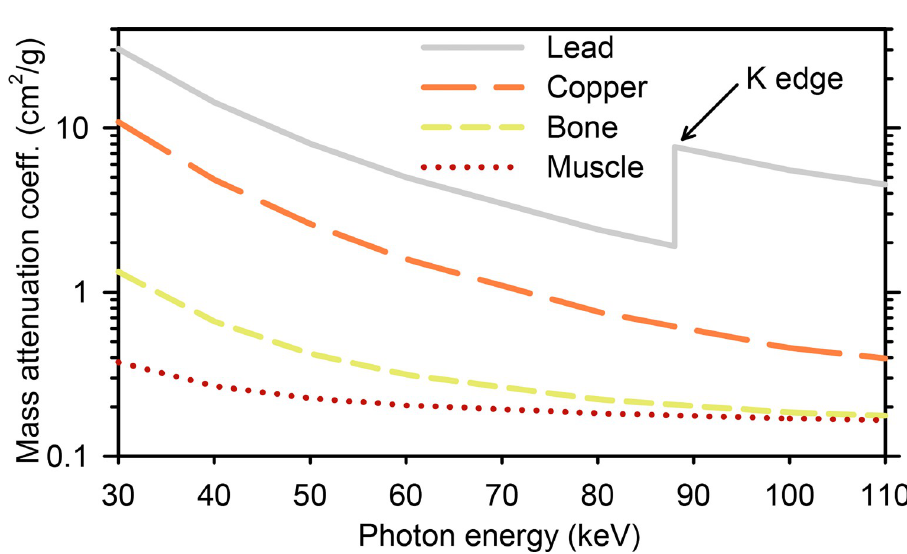
Fig 3. X-ray mass attenuation coefficients for lead, copper, cortical bone, and skeletal muscle